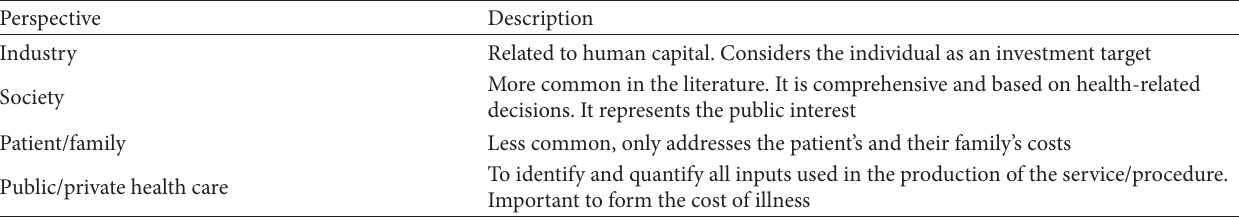
Table 4: Description of the main perspectives used in cost studies.